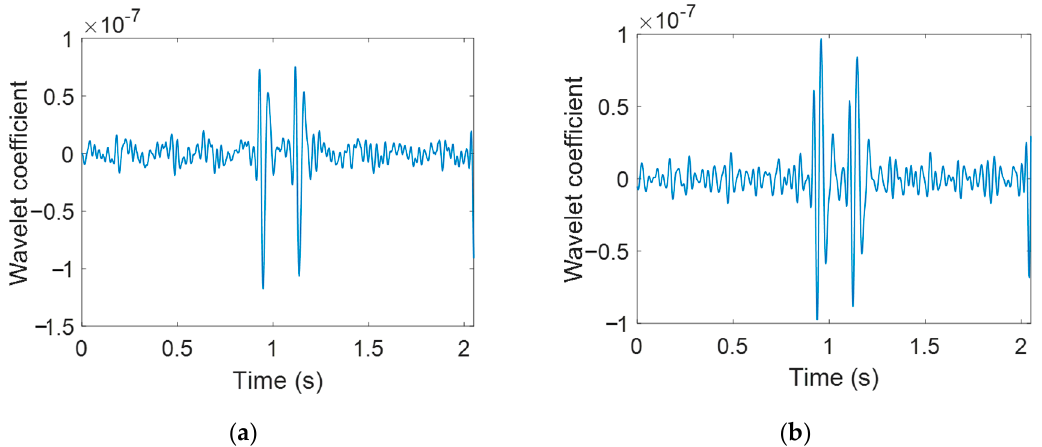
Figure 6. Optimum axle identification using different Daubechies mother wavelet functions: ( a ) db5, scale = 11, ( b ) db8, scale = 13.